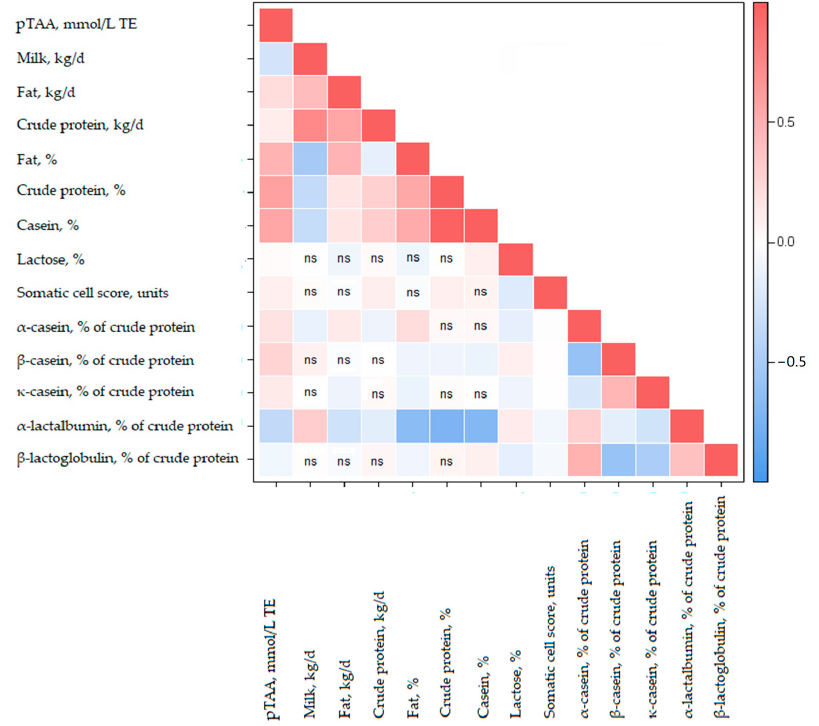
Figure 2. Pearson correlations ( p < 0.001) between sires’ estimated breeding value (EBV; n = 442, accuracy ≥ 0.65) of bovine milk predicted total antioxidant activity (pTAA) expressed as mmol/L of Trolox equivalent (TE) and EBV of other traits. ns = not